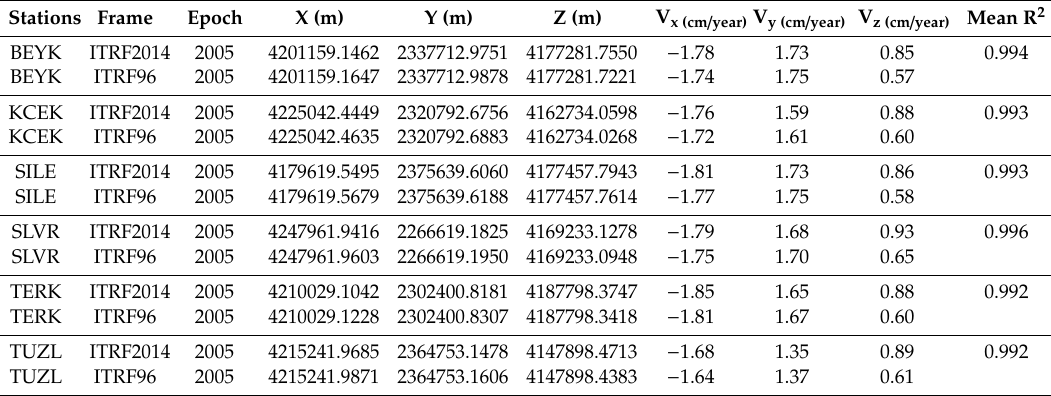
Table 1. Reference coordinate values and velocities of the six test